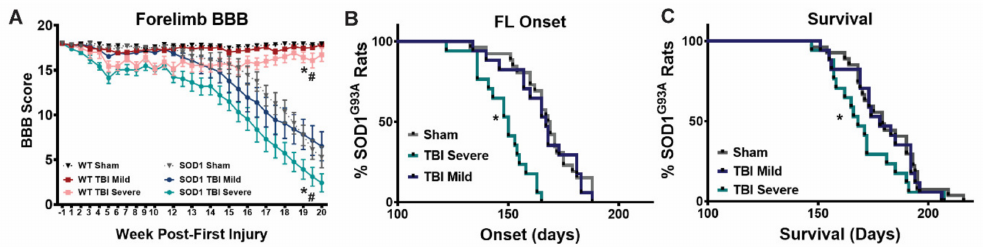
Figure 4. SOD1 rats with initial severe symptoms following repeat TBI exhibit earlier onset and shortened survival. ( A ) Forelimb BBB scoring revealed that WT TBI rats with initial severe symptoms maintain a significant, mild level of paralysis throughout the study, relative to both WT sham and mild TBI. When grouped by injury severity, SOD1 rats in the severe group experienced ( A , B ) an earlier decline in forelimb motor function and ( C ) shortened survival time relative to SOD1 rats in the sham and mild TBI groups. TBI rats exhibiting only mild initial symptoms did not differ from sham SOD1 rats in terms of disease onset and survival. (( A ) * WT sham vs WT TBI Severe, * SOD1 Sham vs SOD1 TBI Severe, # SOD1 vs WT (all groups), Two-way ANOVA p < 0 .05. ( B , C ) Wilcoxon’s signed rank test * p < 0